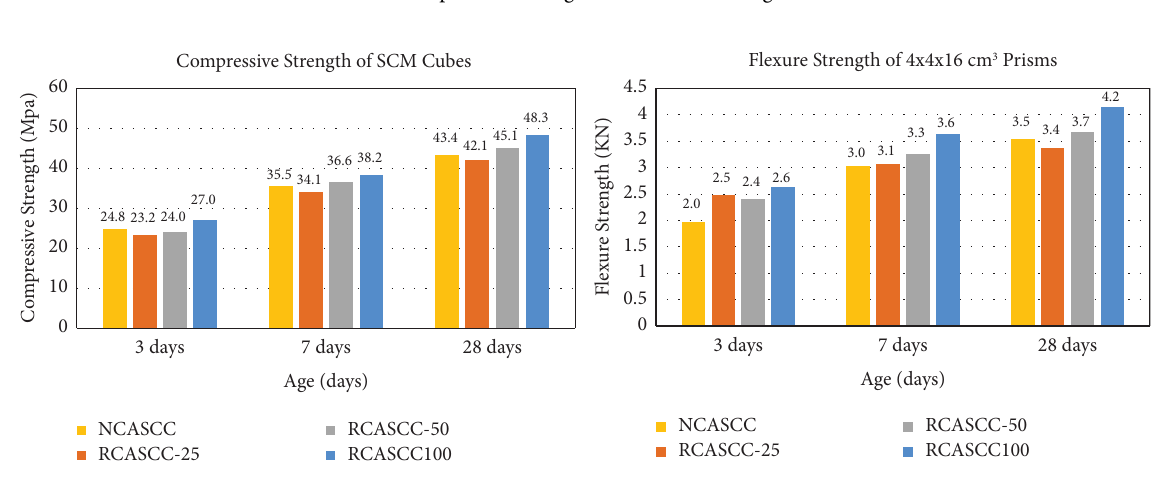
Figure 6: Compressive strength and fexural strength of SCM.